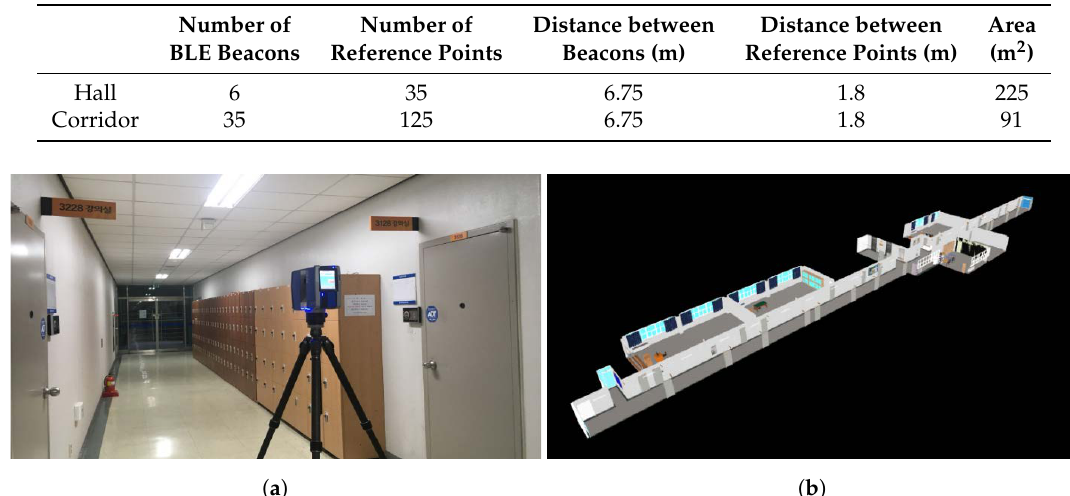
Table 3. Experimental conditions of testbeds.